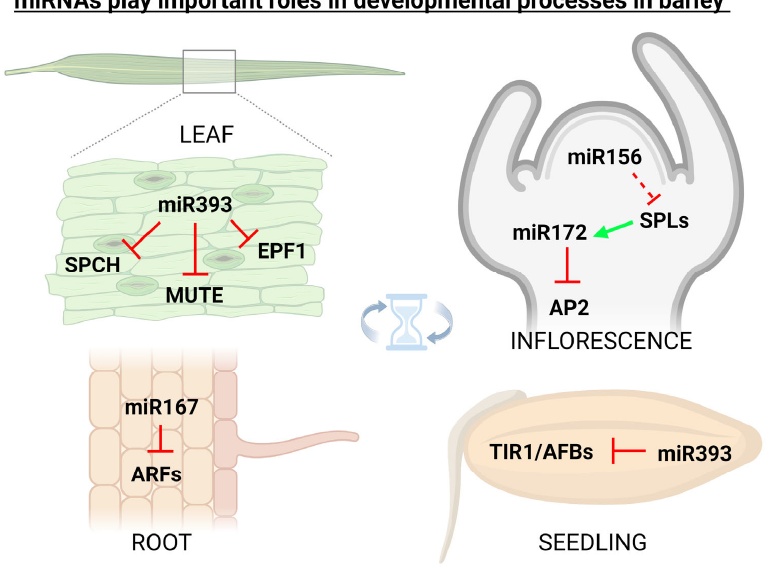
Figure 2. miRNAs play important roles also in the developmental processes. In spring barley ( Hordeum vulgare ), specific miRNAs were linked with the targets involved in the regulation of flowering, root development, seed germination, and also with stomata development. Inhibition is indicated by the red ┴ mark, while positive effect by the green arrow. This figure was created using BioRender (https://biorender.com/; accessed on 20 June 2022). Besides the non ‐ stress conditions, miRNAs play key roles in gene expression regulation in response to a variety of abiotic stimuli, including several stress responses. In plants, their involvement in many abiotic stress responses including heat stress responses, low ‐ temperature responses, drought exposure responses, carbon dioxide responses, light stress responses, or gamma radiation responses was reported [68–72]. Specifically in barley, miRNAs responsive to salinity stress [73–76], drought [77–81], nitrogen [82], boron [83], phosphorus [84,85], aluminum [74,86,87], cadmium [88], cold deacclimation [89], heat stress [90], and possibly to light [21] were identified till date. A chronological summary of the most impactful miRNA studies in barley (starting from 2010) can be found below in Table 1. Table 1. Chronological summary of studies dealing with miRNAs in barley species and most important results obtained. Title of the Study and Reference